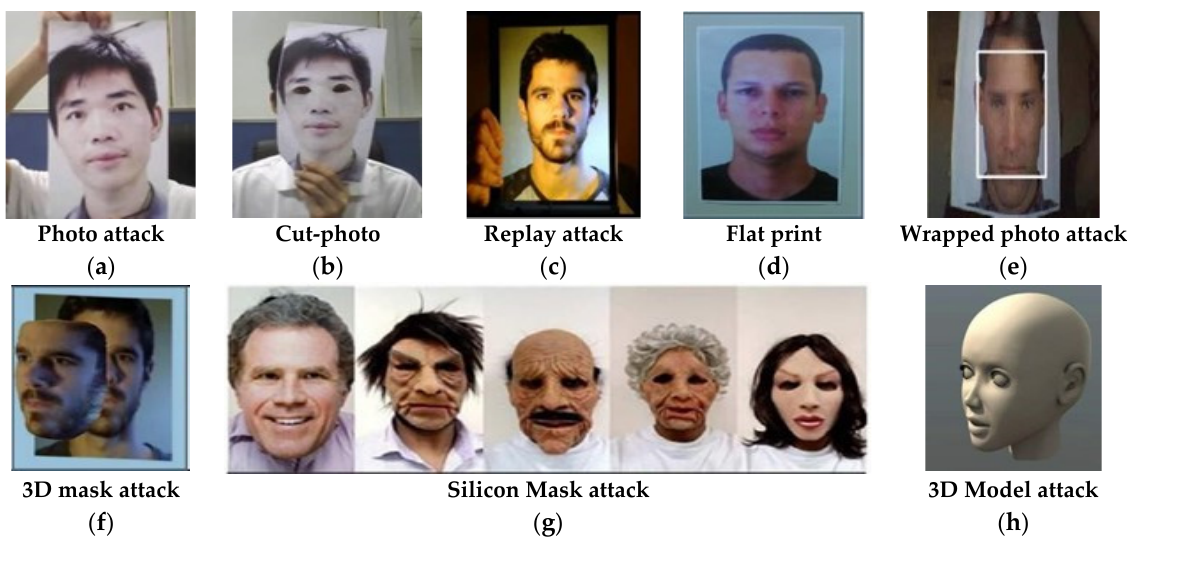
Figure 6. Sample Face spoofing attacks ( a ) Photo attack sample from OULU-NPU dataset [39] ( b ) Photo cut attack OULU-NPU attack [39] ( c ) Replay Attack Sample [40] ( d ) Flat Printed photo attack ( e ) Wrapped photo attack ( f ) 3D Mask generated using Face Construction using front-side faces ( g ) Sample 3D Latex mask from MLFP DB [41], ( h ) 3D model attack [42].